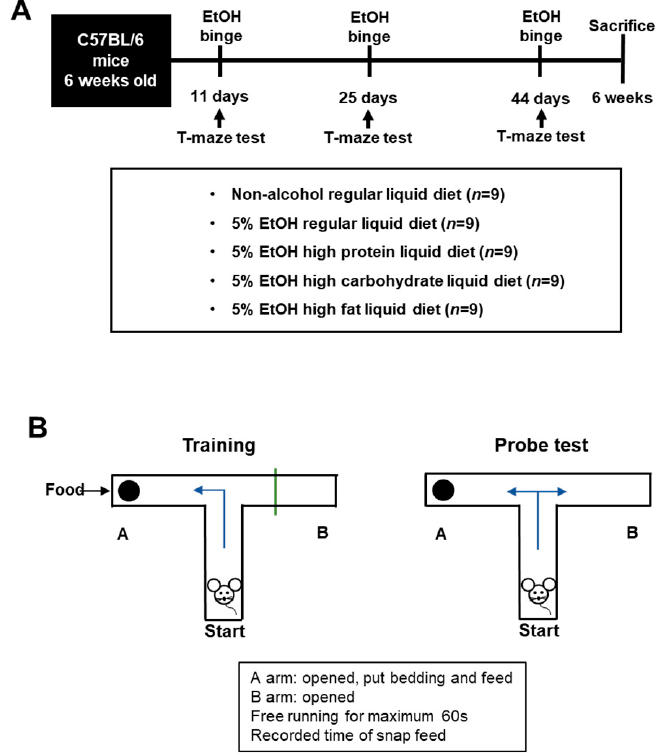
Figure 1. Animal experiment. ( A ). Mice were sub-divided into five groups ( n = 9/group; normal regular liquid diet, control (5% EtOH liquid diet + regular liquid diet), high carbohydrate (5% EtOH + HCD), high fat (5% EtOH + HFD), and high protein (5% EtOH + HPD)) and subject to the indicated conditions for six weeks. ( B ). Schematic of T-maze appliance for working memory